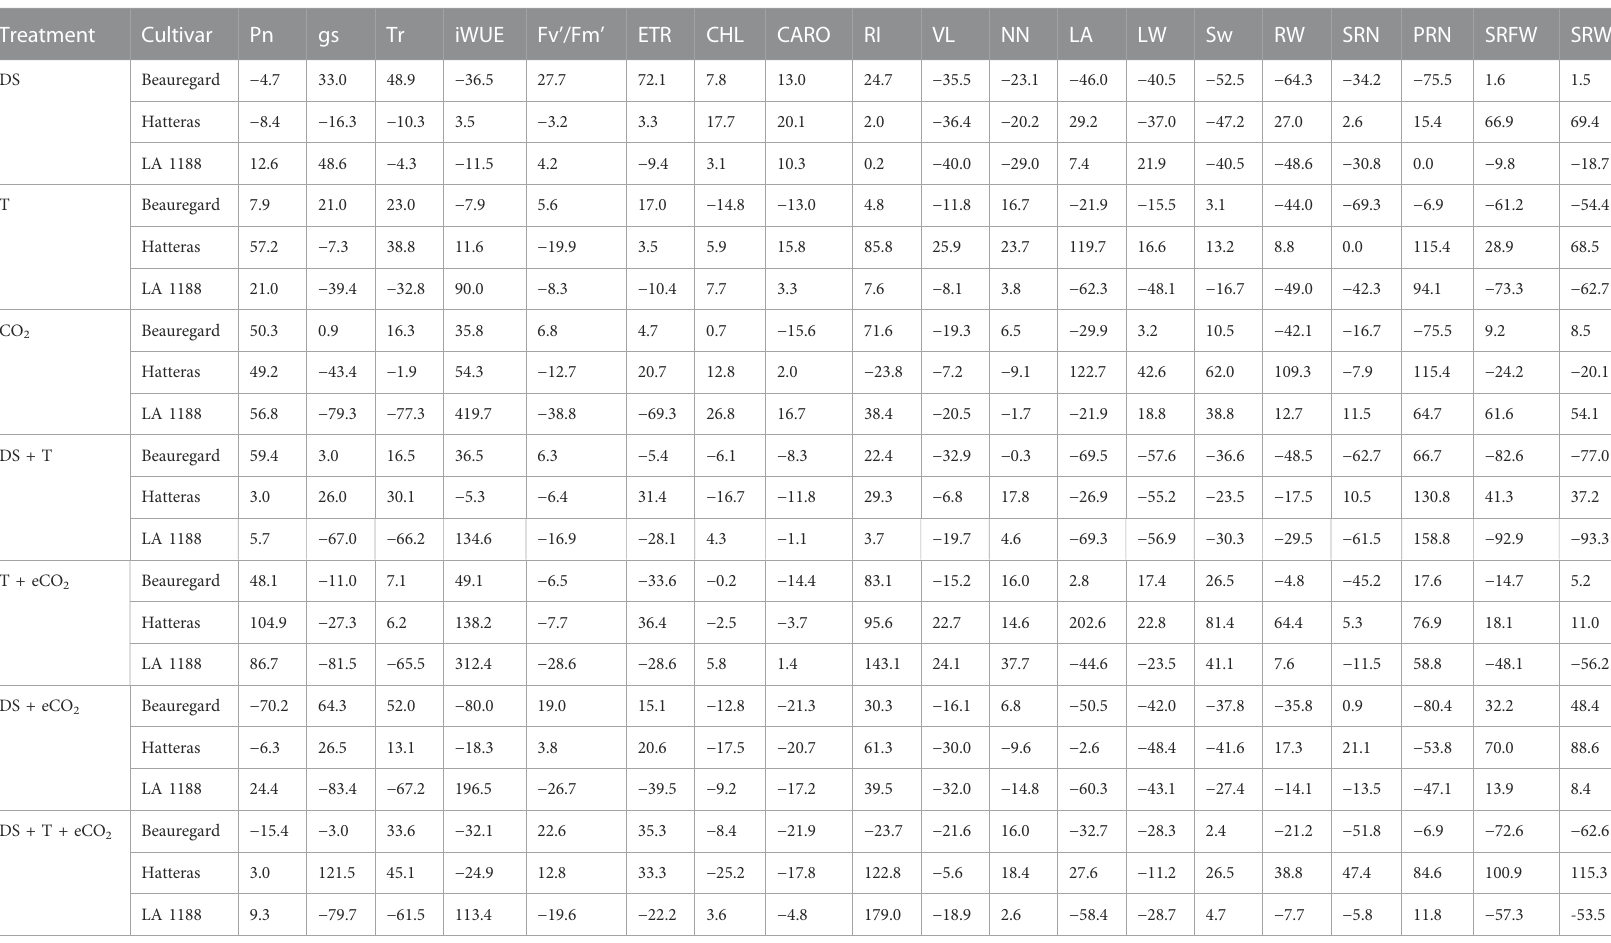
TABLE 3 Percentage changes in the vegetative, physiological, and photosynthetic parameters of three sweetpotato cultivars (drought, DS; high temperature, T; elevated CO 2 , eCO 2 ) and their interactions. Data for each cultivar are the mean ( n = 6). Values indicate treatment-induced decrease ( “ − ” ) or increase ( “ + ” ) compared to control.